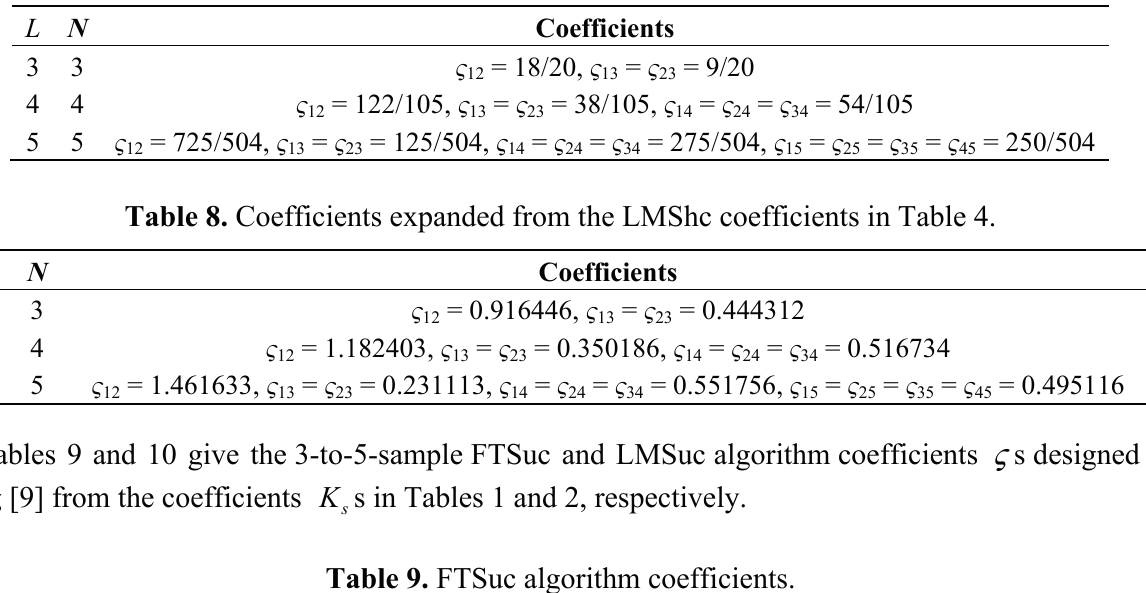
Table 7. Coefficients expanded from the FTShc coefficients in Table 3.